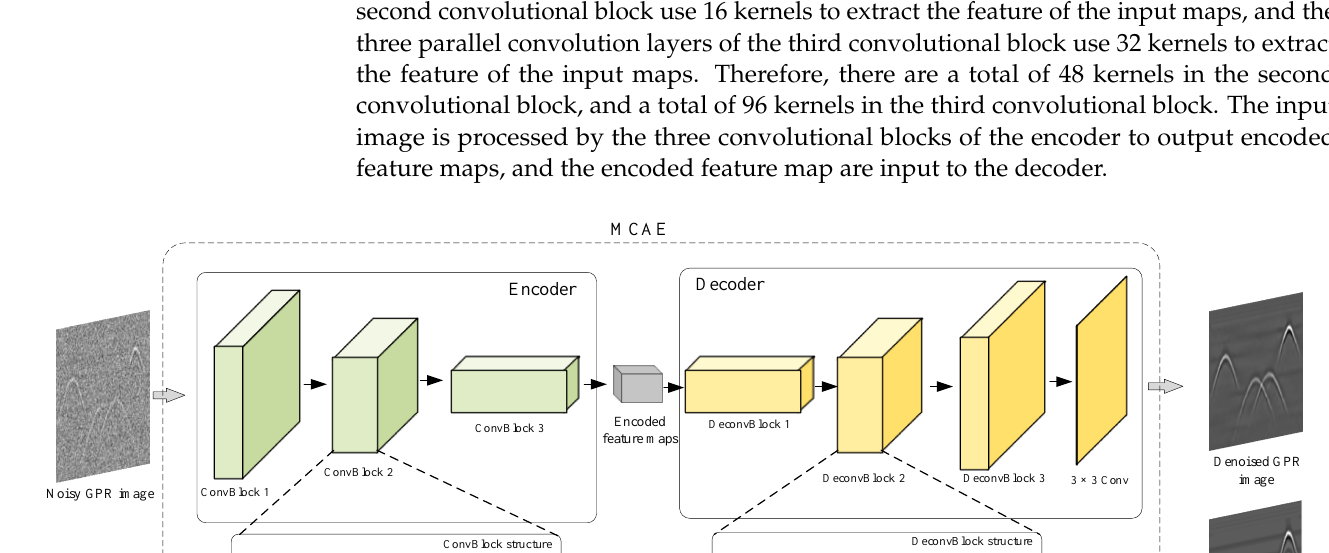
where h k × k indicates the value of the output feature map at position ( m , n ), w c m , n value of the c -th channel of the convolutional kernel at position ( i , j ), x c